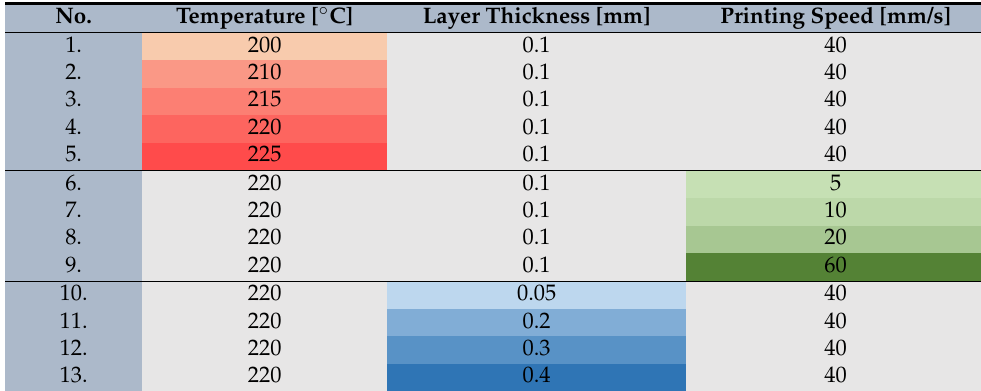
Table 1. Production parameters of specimens.